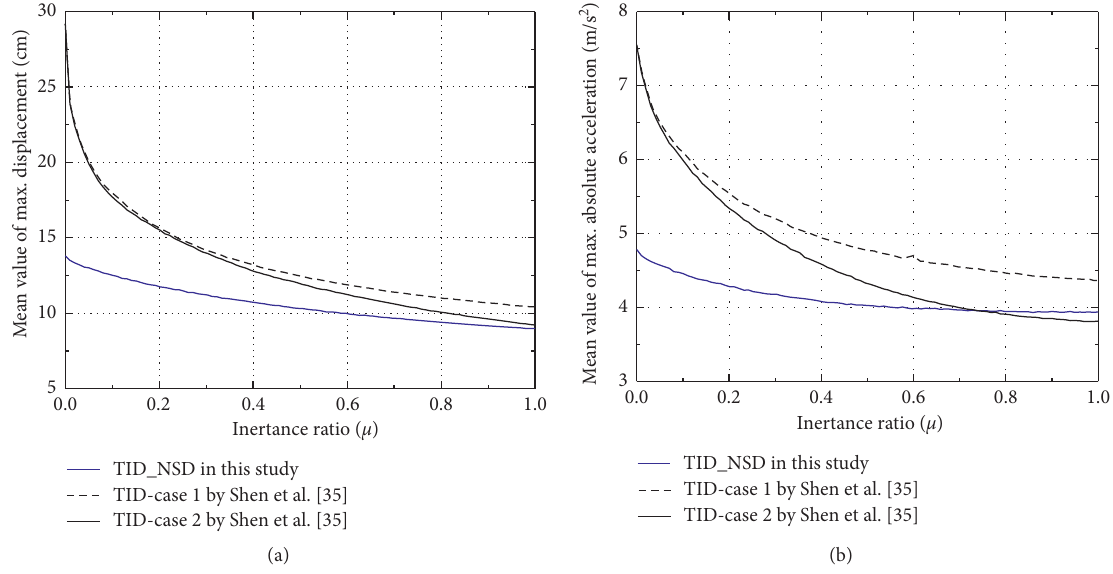
Figure 6: Effect of inertance ratio μ on the response of the TID_NSD system under 20 earthquake records. (a) Mean displacement. (b) Mean absolute